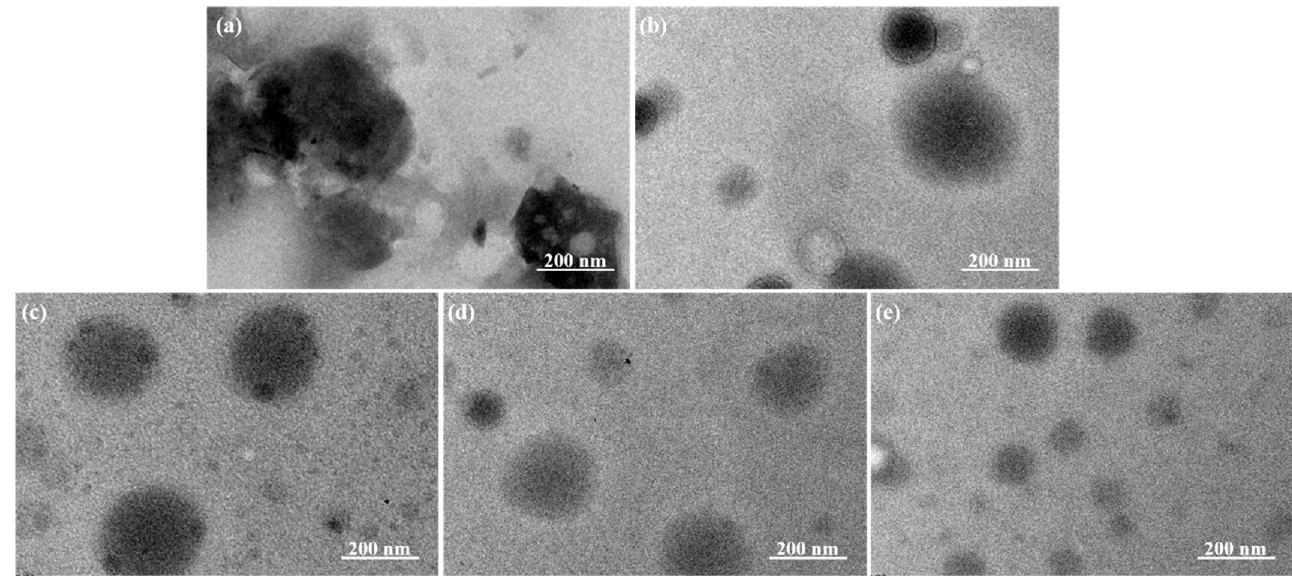
Figure 6. TEM images of ( a ) SA aggregates, ( b ) HAD, ( c ) OAD, ( d ) DAD, and ( e ) LAD self-aggregated micelles. The colloidal property of AAD self-aggregated micelles was further investigated by dynamic light scattering (DLS). As shown in Figure 7a, the AAD self-aggregated micelle exhibited a narrow hydrodynamic diameter (d H ) distribution in comparison with the SA aggregates. The average d H of SA, HAD, OAD, DAD, and LAD self-aggregated mi- celles were 570.2 nm (PDI = 0.49), 285.3 nm (PDI = 0.29), 245.0 nm (PDI = 0.36), 210.2 nm (PDI = 0.32), and 180.5 nm (PDI = 0.21), respectively. As the alkane chain increased, the average d H gradually decreased. The growth of the carbon chain length of the hy- drophobic side groups enhanced the attraction between the ends of the tail, which caused strong hydrophobic associations, resulting in the reduction of d H . These results were attributed to the rigid and extended chain characteristics of SA molecules in aqueous media that led to bigger diameters for the SA aggregates [45], while the grafting of the hydrophobic side groups of the hexyl, octyl, decyl, and lauryl groups broke the intramolec- ular hydrogen bonds and enhanced the molecular flexibility that enabled itself to curl freely to form smaller diameters for the AAD self-aggregated micelle [35,45]. Moreover, from Figure 7b, due to the enhancement of molecular flexibility, which exposed more residual free-curling carboxyl groups on the surface, the SA, HAD, OAD, DAD, and LAD self-aggregated micelles revealed the relatively high negative zeta potential at − 27.4, − 44.8, − 39.2, − 38.3, and − 34.4 mV, respectively, as a result of the presence of the negatively charged carboxyl groups [30]. The zeta potential of the AAD self-aggregated micelle was significantly lower than that of the SA aggregates, which was attributed to the fact that the AAD with both the hydrophilic main chains and hydrophobic side groups was able to self-aggregate into core-shell architectures where the hydrophilic carboxyl groups were ex- posed, thus reducing its zeta potential. It was reported that the self-aggregated micelle was stable in aqueous solution when its zeta potential was lower than − 30 mV [7,46]. Therefore, the HAD, OAD, DAD, and LAD self-aggregated micelle could be significantly stable in aqueous solution due to the strong electrostatic repulsion that can prevent aggregation among the